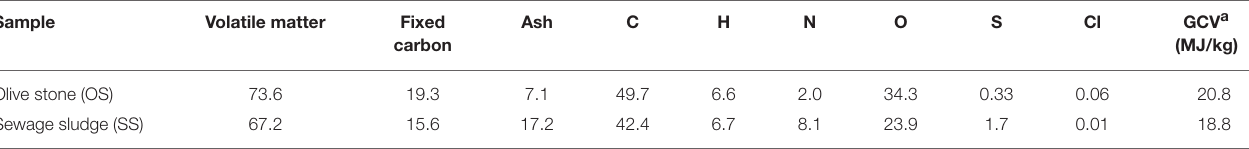
TABLE 1 | Proximate and ultimate analyses and calorific value of the samples (% dry weight). Sample